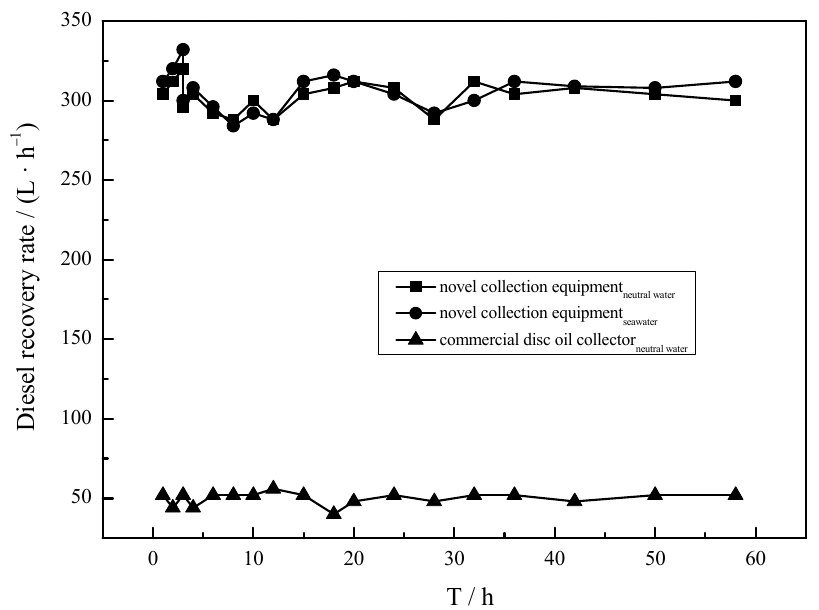
Figure 9. The operation stability of collection equipment under 58 h continuous operation.